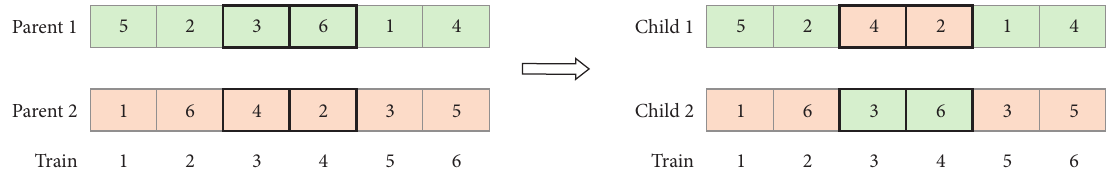
Figure 6: Illustration of the crossover